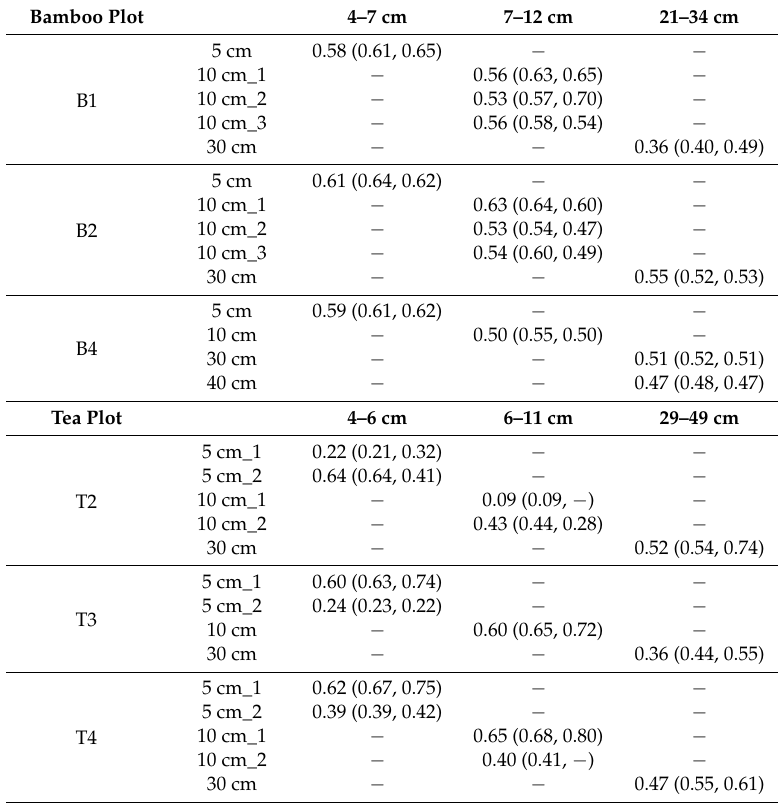
Figure 2. Images of the ( a ) moso bamboo and ( b ) green tea plots, and ( c ) image and ( d ) diagram of the soil respiration monitoring instrument. Table 1. Hourly (daily, monthly) R 2 between observed and simulated soil water content.